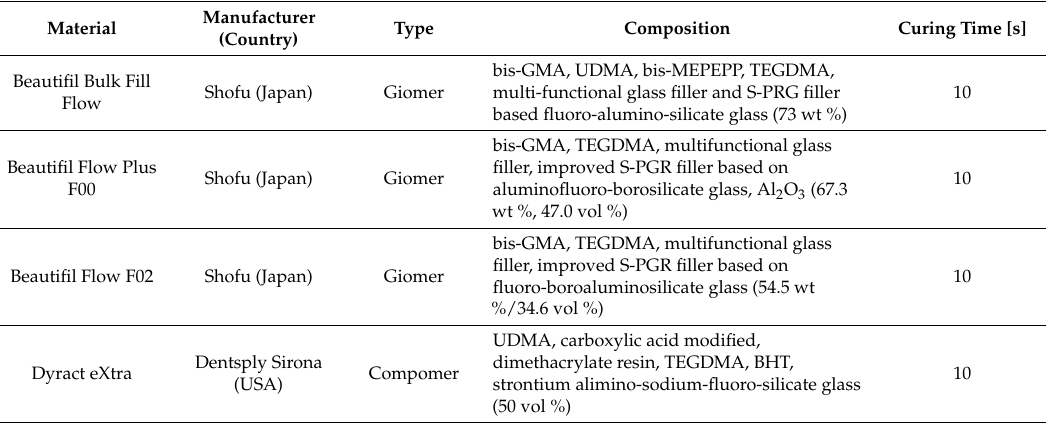
Table 1. The composition and curing time of investigated